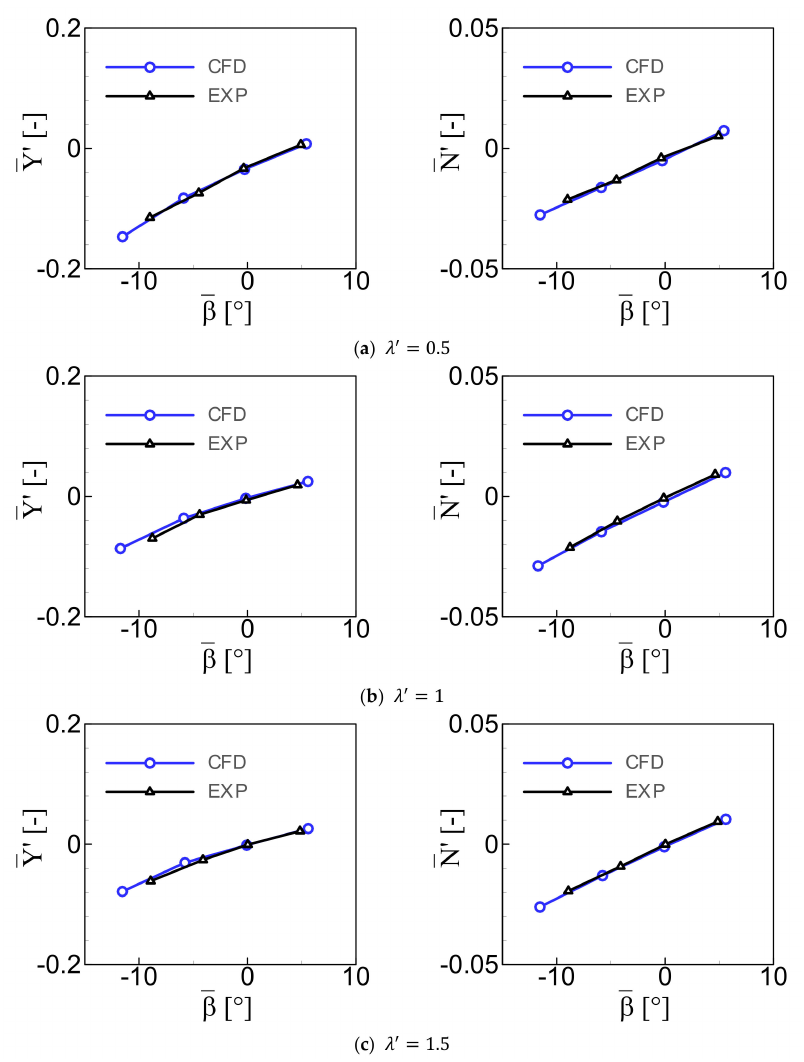
Figure 12. Mean sway force and yaw moment versus the mean oblique angle in beam